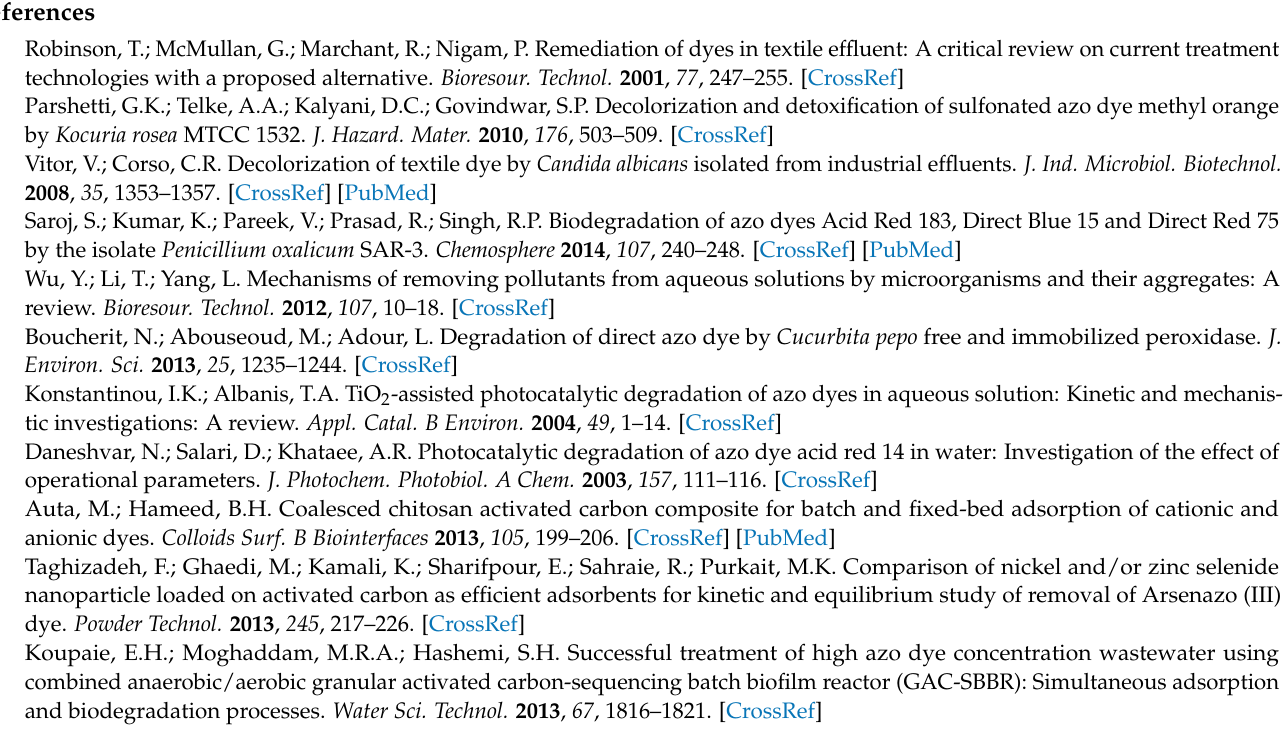
Figure S4: ESI-MS(-) of N,N-dimethylbenzenamine radical anion standard with molecular formula C8H10N (MDB, m / z = 120.0439), Figure S5: ESI-MS(-) of MO reaction mixture, Mass/Charge – 100-600 [Da], Figure S6: ESI-MS(+) of MO standard with molecular formula C14H16N3SO3 (MMOH2, m / z =306.0918), Figure S7: ESI-MS(+) of benzenesulphonic acid radical cation standard with molec- ular formula C6H5O3SH2 (MBAH2, m / z – 159.0107), Figure S8: ESI-MS(+) of N,N-dimethyl-p- phenylenediamine radical cation standard with molecular formula, C8H11N2H2 (MDH, m / z – 137.1072), Figure S9: ESI-MS(+) of N,N-dimethylbenzenamine radical cation standard with molecular formula C8H10NH2 (MDBH2, m / z = 122.0969), Figure S10: ESI-MS(+) of MO reaction mixture, Mass/Charge – 100-700 [Da], Figure S11: ESI-MS(+) + FA of MO standard with molecular formula C14H16N3SO3 (MMOH2, m / z =306.0918), Figure S12: ESI-MS(+) + FA of benzenesulphonic acid radical cation standard with molecular formula C6H5O3SH2 (MBAH2, m / z – 159.0107), Figure S13: ESI-MS(+) + FA of N,N-dimethyl-p-phenylenediamine radical cation standard with molecular for- mula, C8H11N2H2 (MDH, m / z – 137.1072), Figure S14: ESI-MS(+) + FA of N,N-dimethylbenzenamine rad-ical cation standard with molecular formula C8H10NH2 (MDBH2, m / z = 122.0969), Figure S15: ESI-MS(+) + FA of MO reaction mixture, Mass/Charge – 100-700